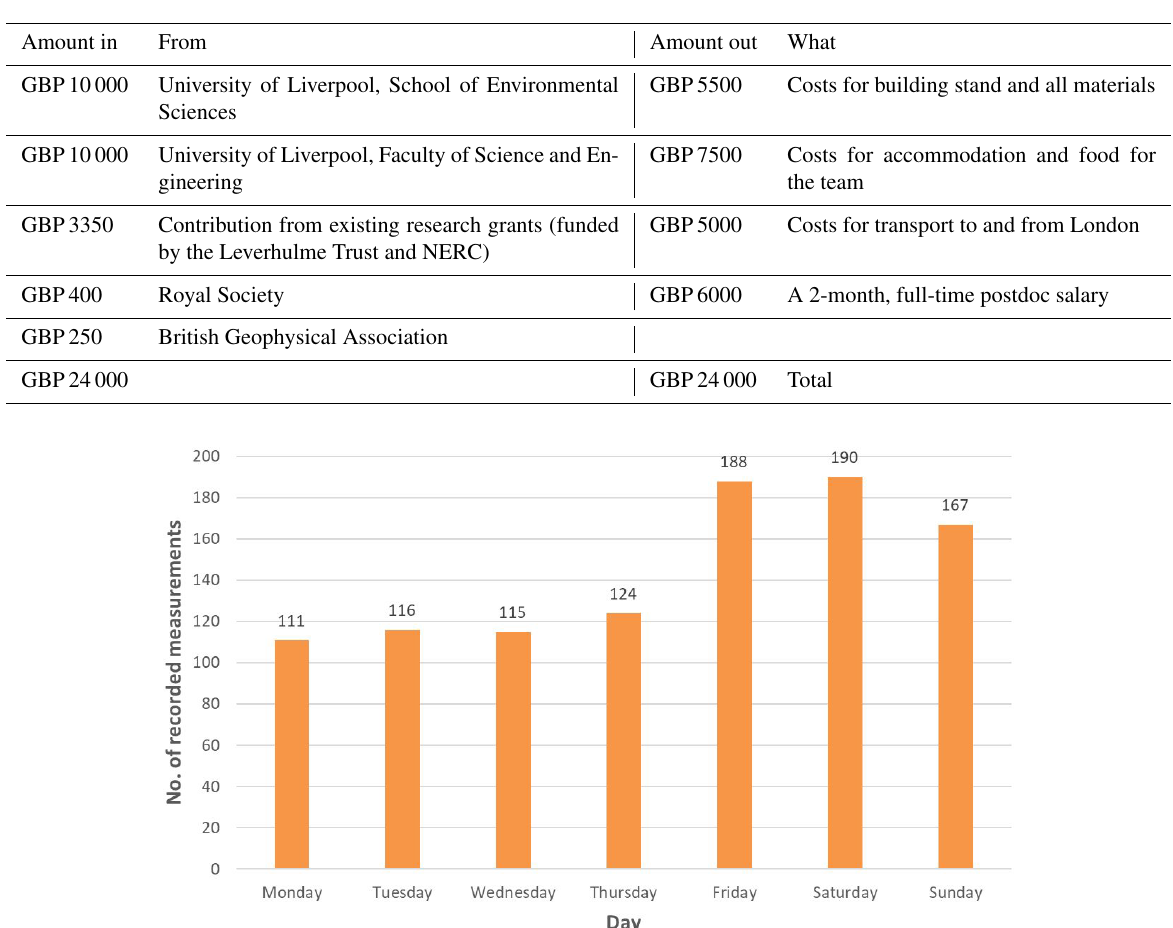
Table 3. Indicative budget and costs of the Magnetic to the Core project.